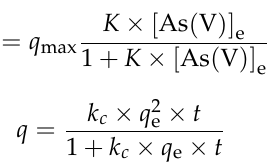
The adsorption kinetics also fits Equation (6) very well ( R 2 ≥ 0.98), with q